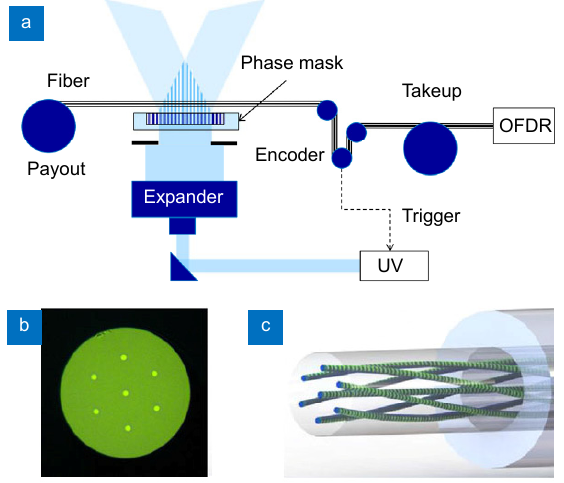
Fig. 7 | ( a ) Reel-to-reel array inscription apparatus allowing continu- ous fabrication of gratings in all cores through UV transparent coat- ing. ( b ) End-view image of a seven-core fiber with coating removed. ( c ) Twisted multicore fiber schematic showing UV transparent coating (right). Bare glass region (left) shown to highlight twisted multicore continuous gratings. Figure reproduced from ref. 44 ,